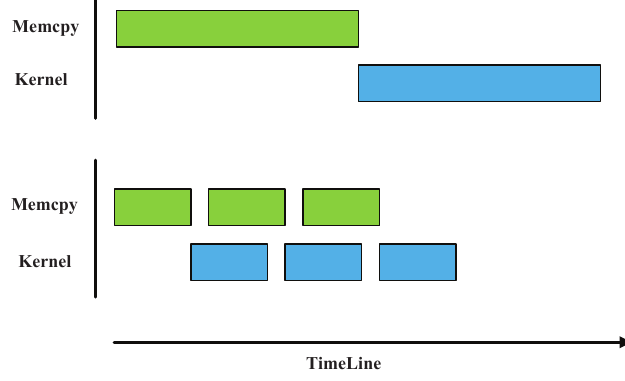
Figure 7. Synchronous and asynchronous execution